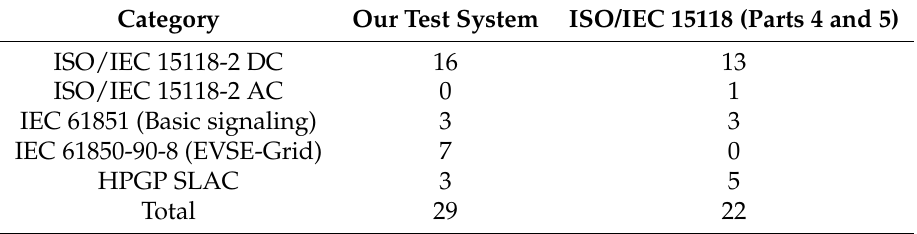
Table 1. Test case coverage. EVSE, EV Supply Equipment; HPGP, Home-Plug Green PHY; SLAC, Signal Level Attenuation